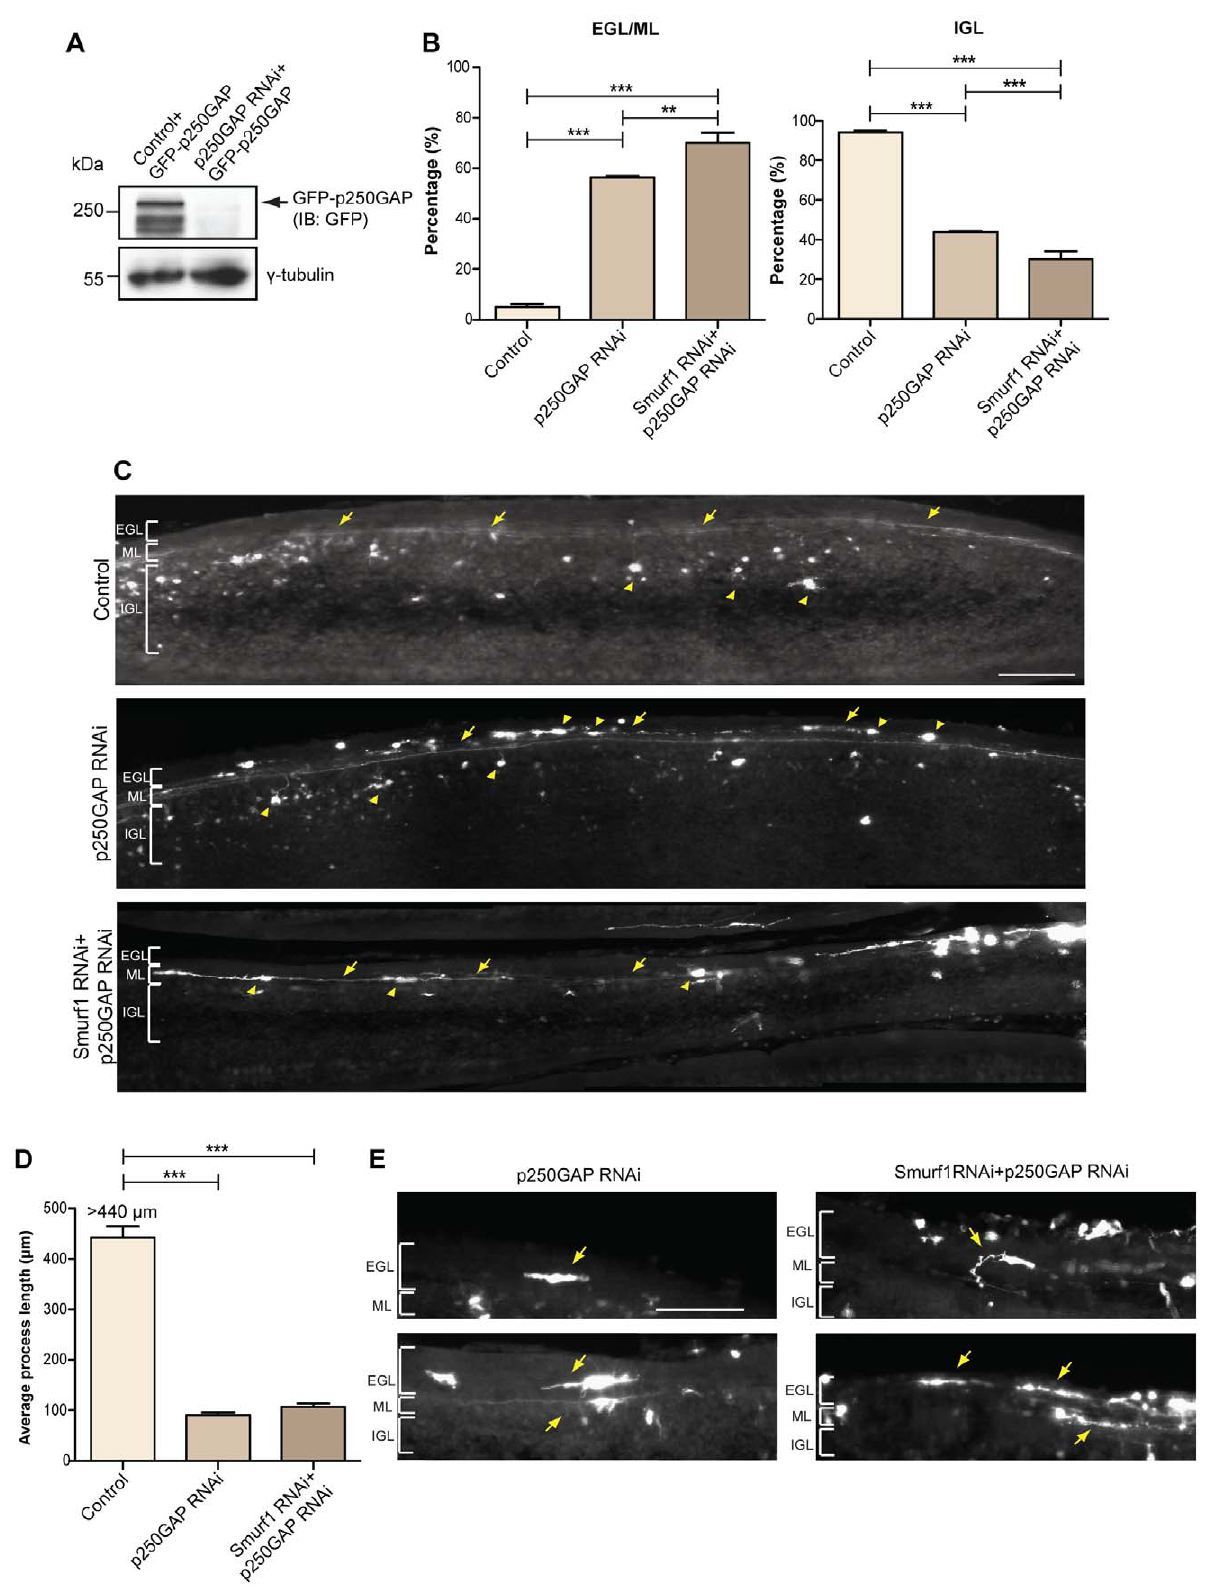
Figure 6. p250GAP promotes migration and axon extension in the developing cerebellar cortex. A. Lysates of 293T cells transfected with control vector U6-CMV-EGFP or U6-p250GAP RNAi-CMV-EGFP (p250GAP RNAi) together with GFP-p250GAP expression plasmid were subjected to immunoblotting with GFP and c -tubulin (loading control) antibodies. B. The control U6-CMV-EGFP plasmid, p250GAP RNAi-CMV-EGFP (p250GAP